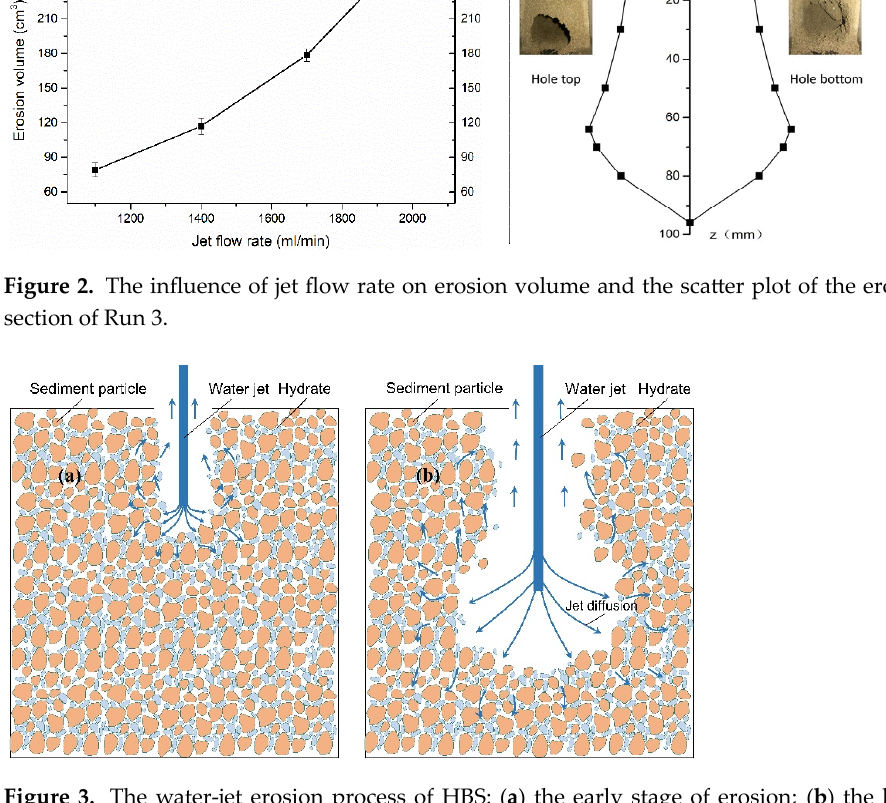
Figure 3. The water‑jet erosion process of HBS: ( a ) the early stage of erosion; ( b ) the later stage of erosion.